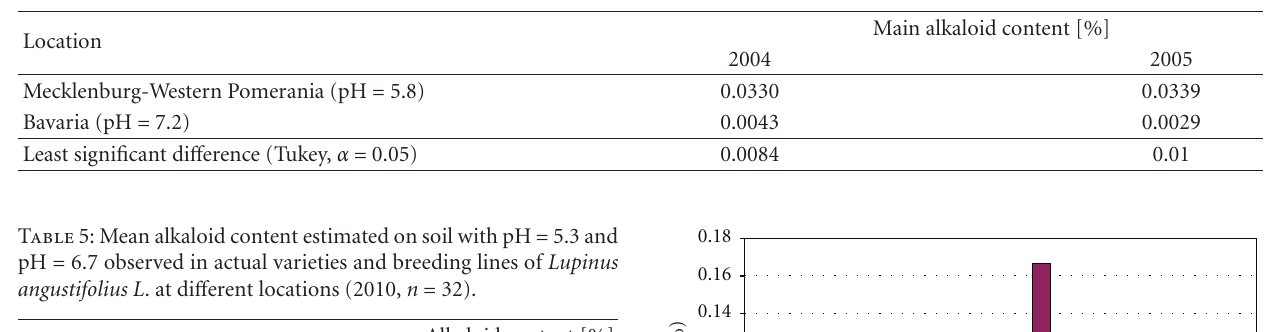
Table 4: Mean alkaloid content estimated on soil with pH = 5.8 and pH = 7.2 observed in cultivars of Lupinus angustifolius at di ff erent locations (2004 and 2005, n = 22).